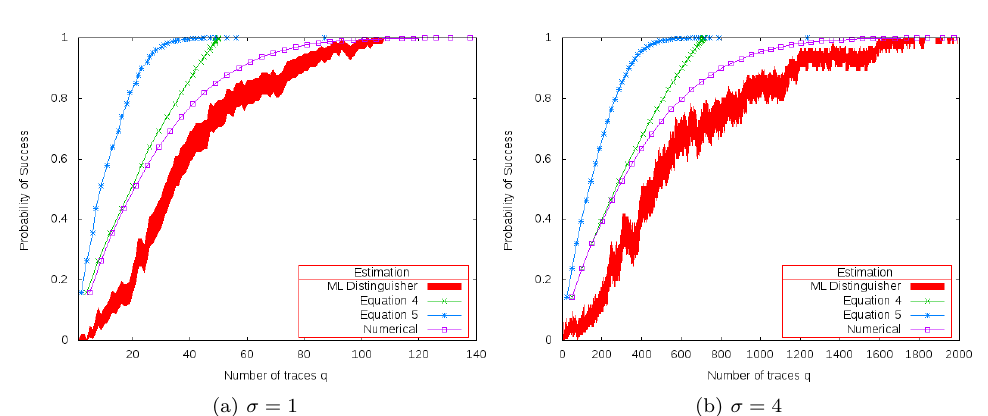
Figure 4: Success rates with monobit leakage.